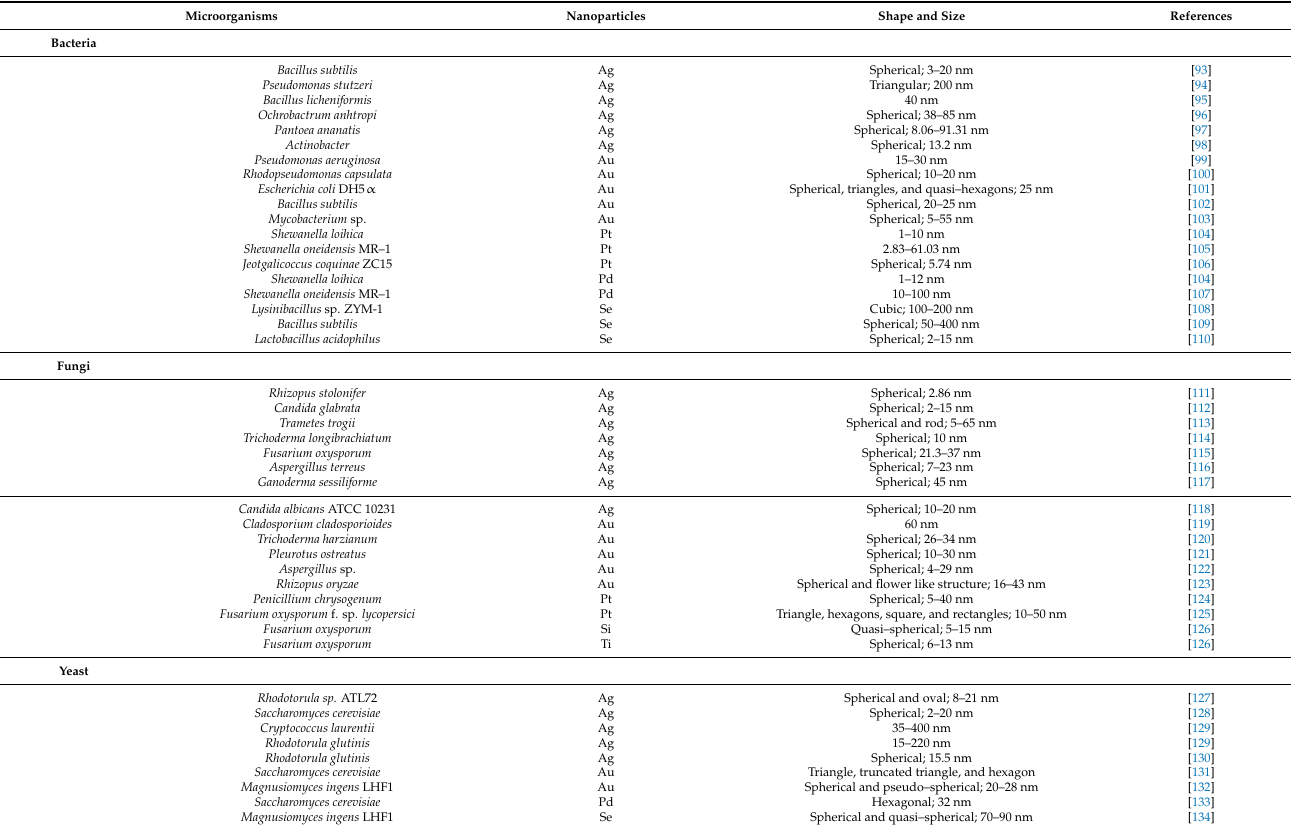
Table 2. Summary on synthesis of metallic nanoparticles by microorganisms. Microorganisms